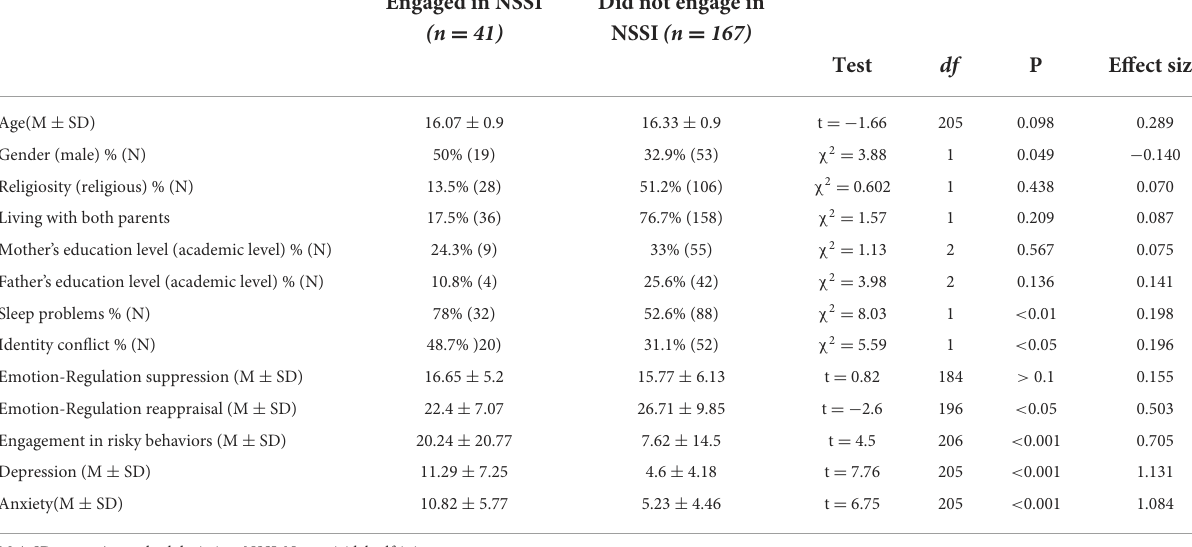
TABLE 2 Demographic characteristics in terms of engagement in non-suicidal self-injury. Engaged in NSSI